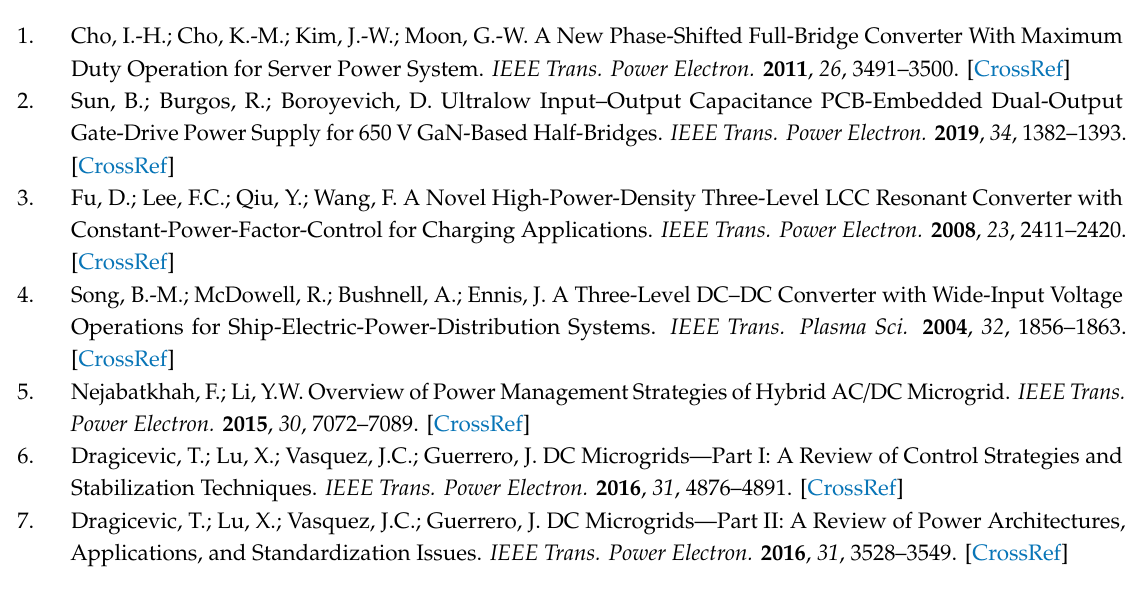
Figure 14. Measured circuit efficiencies of the proposed circuit.